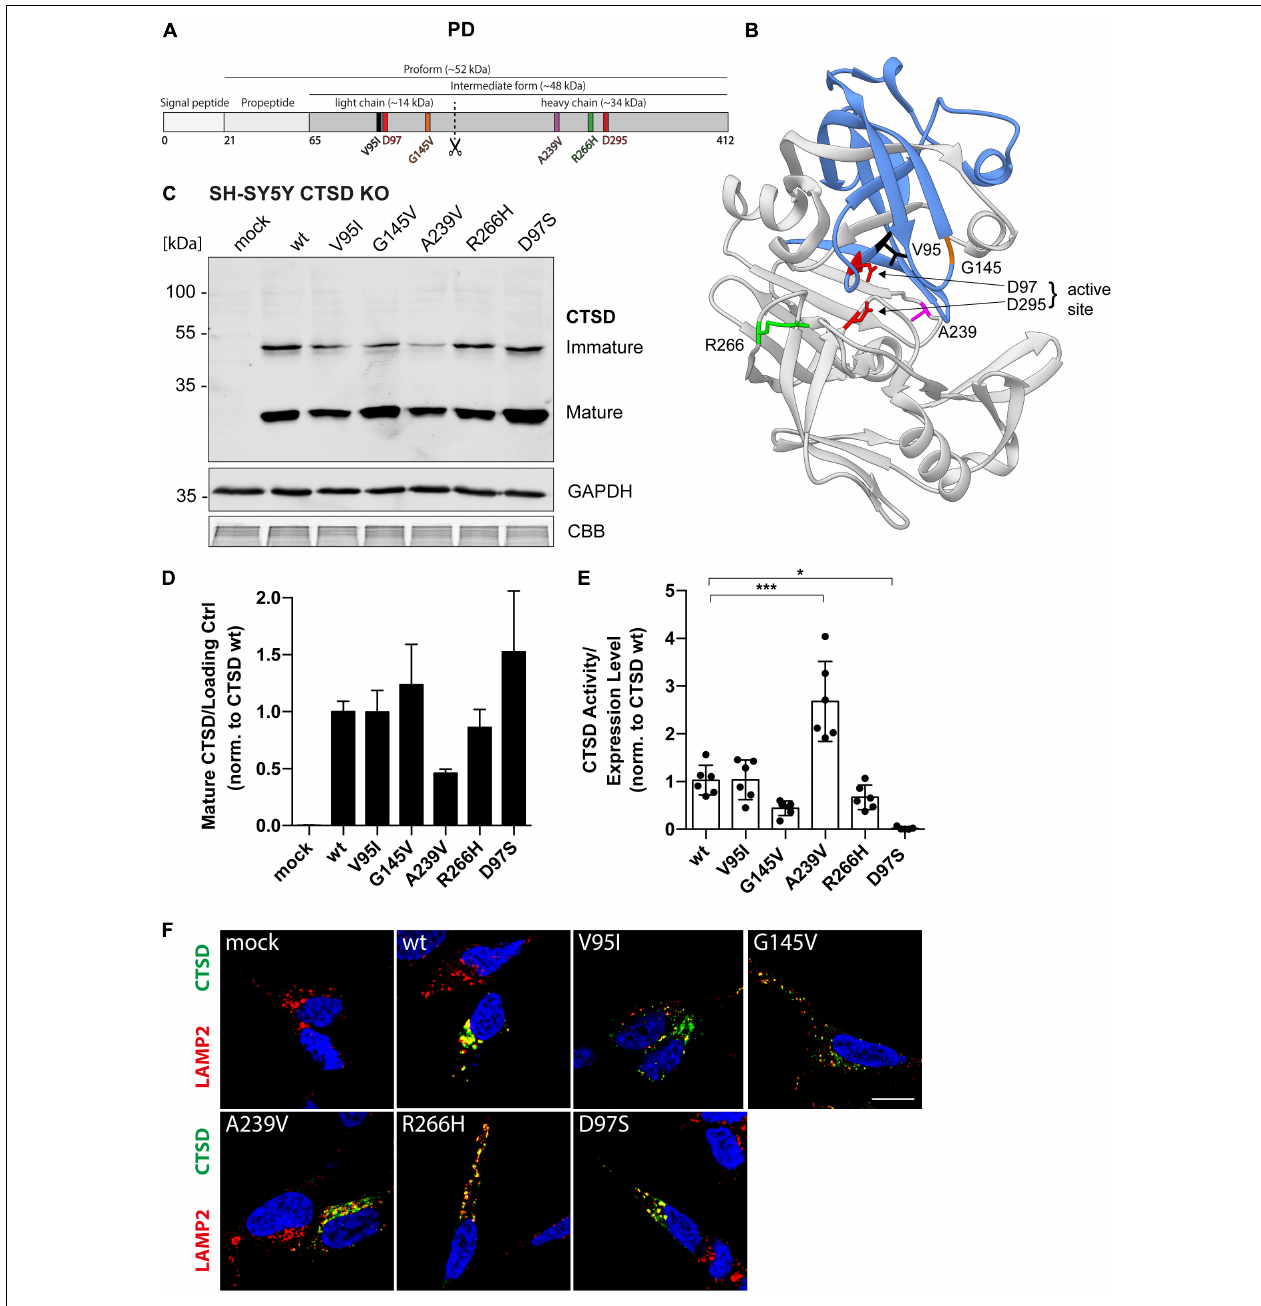
FIGURE 2 | Structural and functional analyses of PD-associated CTSD variants in SH-SY5Y CTSD KO cells. (A) Schematic overview of the CTSD protein (412 aa) and its maturation intermediates (pro- and intermediate form, together referred to as immature form). Mature CTSD consists of a light chain ( ∼ 14 kDa) harboring two of the total four analyzed PD-associated mutations (V95I and G145V) and the heavy chain containing the A239V and R266H mutation. The aspartates D97 and D295 of the active site are shown in red. (B) Crystal structure model of mature CTSD protein consisting of the light chain (blue) and the heavy chain (gray) [PDB-ID: 4OBZ (Gradler et al., 2014)]. Active site residues (D97, D295) are shown in red. Other colors indicate PD associated point mutations (V95, black, light chain; G145, orange, light chain; R266, green, heavy chain; A239, purple, heavy chain). (C) Representative immunoblot of transiently overexpressed CTSD wildtype (wt), enzymatically inactive control (D97S), and PD-associated CTSD variants in SH-SY5Y CTSD KO cells. An anti-CTSD antibody was used for the detection of immature (pro- and intermediate form) as well as mature CTSD (heavy chain, 34 kDa). GAPDH and CBB were used as loading control. (D) Quantification of mature CTSD western blot signal intensity of CTSD variants normalized to loading control GAPDH and expressed relative to CTSD wt ( n = 4). (E) CTSD activity was assessed in whole cell lysates by fluorogenic peptide cleavage assays and normalized to CTSD wt ( n = 7). (F) Immunostaining analysis of CTSD (green) and lysosomal protein LAMP2 (red) in SH-SY5Y CTSD KO cells overexpressing CTSD wt or PD-associated variants. Nuclei are stained with DAPI (blue). Scale bar: 20 µ m. More confocal images also showing single channels can be found in Supplementary Figure 4 . All statistical analyses were performed by using a one-way ANOVA followed by a Tukey’s multiple comparison test. *p < 0.05, *** p < 0.001; n.s., not significant.